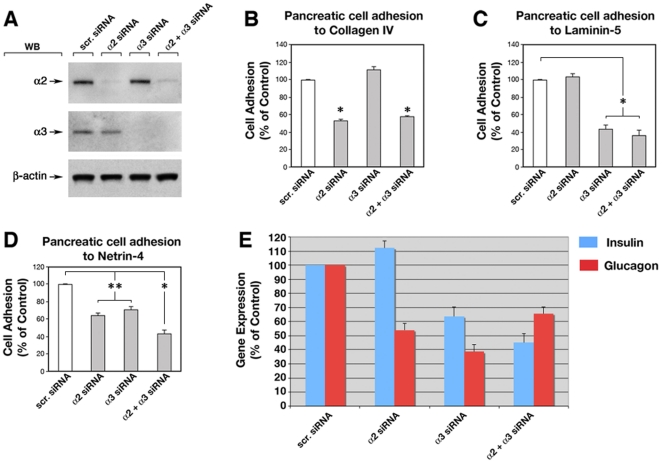
Knock-down of α2 and α3 integrin subunits by siRNA affects pancreatic cell adhesion to Netrin-4 and expression of islet-specific differentiation gene expression.(A) Western blot analysis of pancreatic cells transfected with siRNA specific for α2 and α3 integrin subunits effectively knocked-down α2 and α3 protein expression. Down-regulation of α2 and α3 integrin subunits in pancreatic cells resulted in a significant reduction of adhesion to Collagen IV (B) Laminin-5 (C), and to Netrin-4 (D), as well as a decrease in glucagon and/or insulin gene expression when cultured overnight on Netrin-4 (E). Data presented are representative of three independent experiments. Data presented in B, C and D are representative of n = 3, *p<0.001 and **p<0.01 as determined by ANOVA followed by post-test Bonferroni's multiple comparison test.